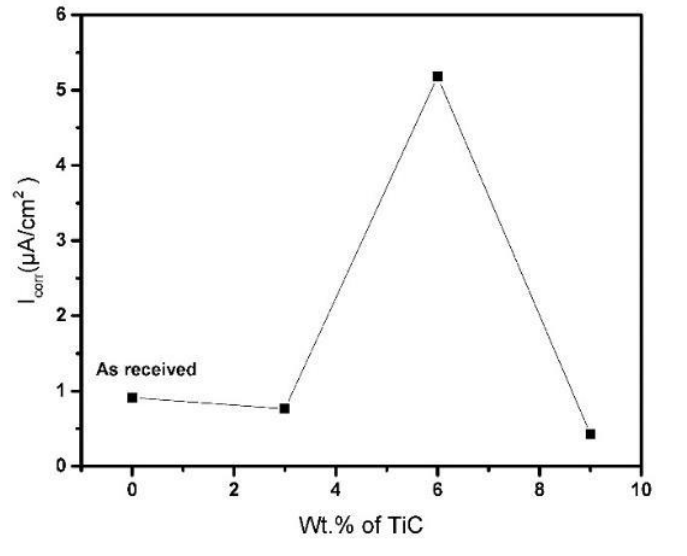
Fig. 17. Variation of current density with the wt.% of TiC in Al7075